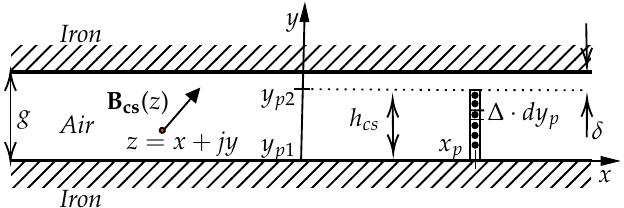
Figure 2. Vertically oriented current sheet of length h cs , powered by a current density ∆ flowing outwards the paper plane, whose extremes are situated at z p 1 and z p 2 between two smooth iron surfaces ( g = 11.5 mm and δ = 1.5